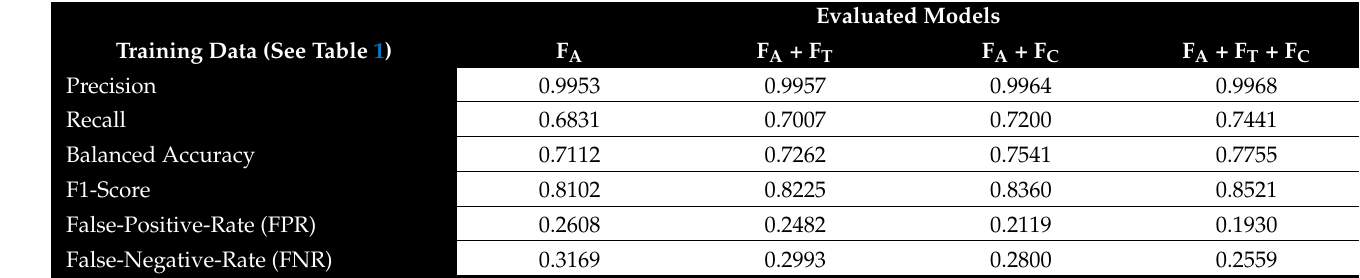
Table 2. Evaluation of the differently trained XGBoost